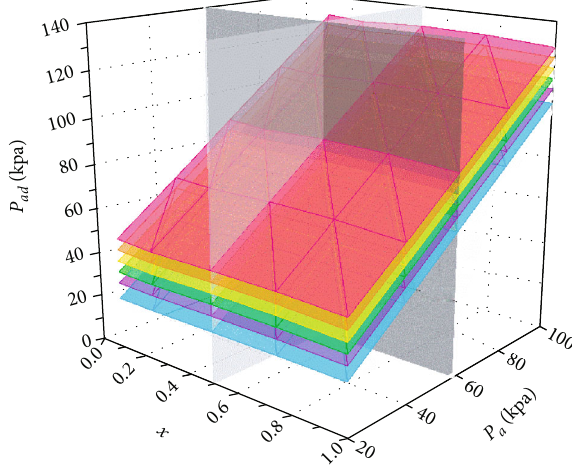
Figure 8: Relation of actuator diaphragm pressure P valve opening x and ambient pressure P a